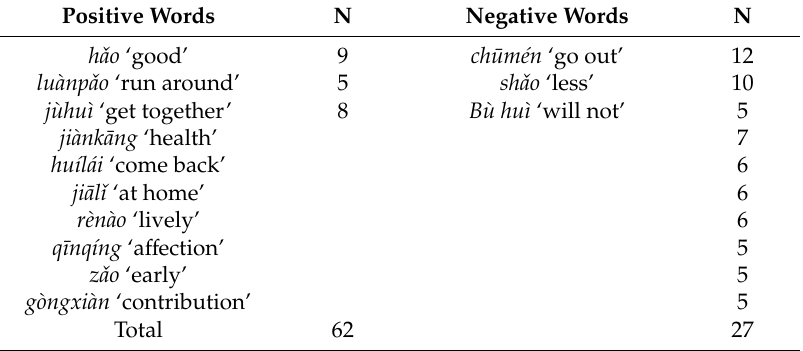
Table 5. Words with frequencies of 5 and over that appeared in ‘Gentle’ banners; N = 89. Positive Words